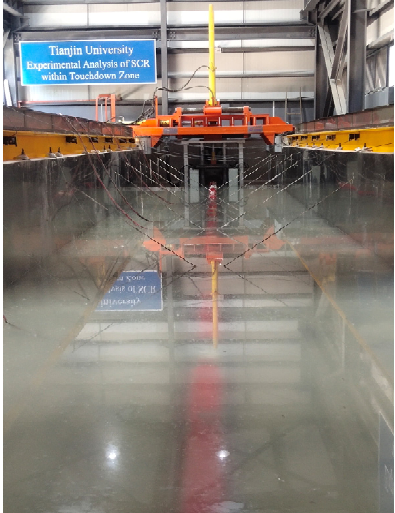
Figure 21. Installation of displacement transducers.